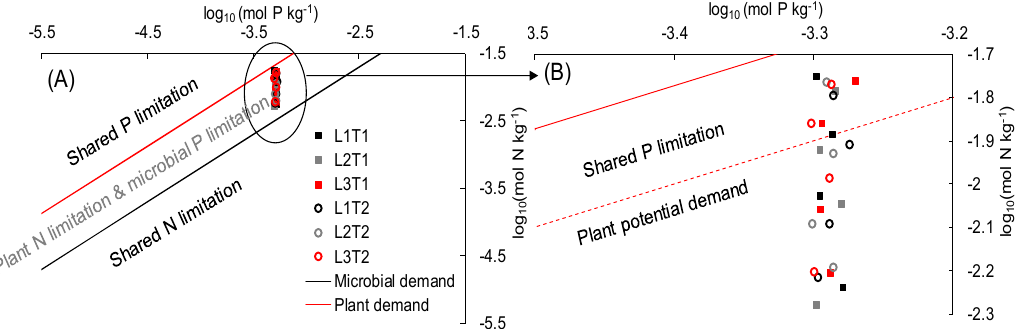
Figure 5. Conceptual scheme of plant-microbe interactions based on plant and microbial N / P CR . Plant demand for P (in relation to N demand) is lower than microbial demand for P. ( A ) pakchoi su ff ered N limitation and microorganisms su ff ered P limitation at N / P SOIL between plant and microbial N / P CR ; ( B ) pakchoi and microorganisms shared P limitation when N / P plant decreased with light intensity. CR